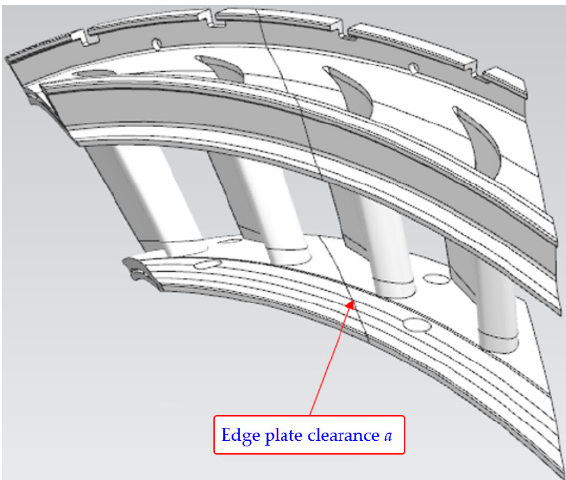
Figure 5. Schematic diagram of edge plate clearance for turbine blades.